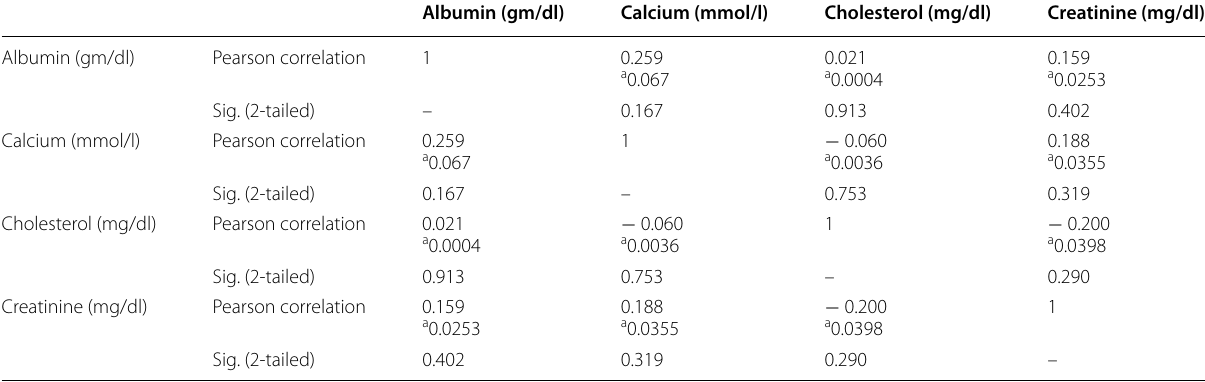
a R 2 value was obtained from the graph